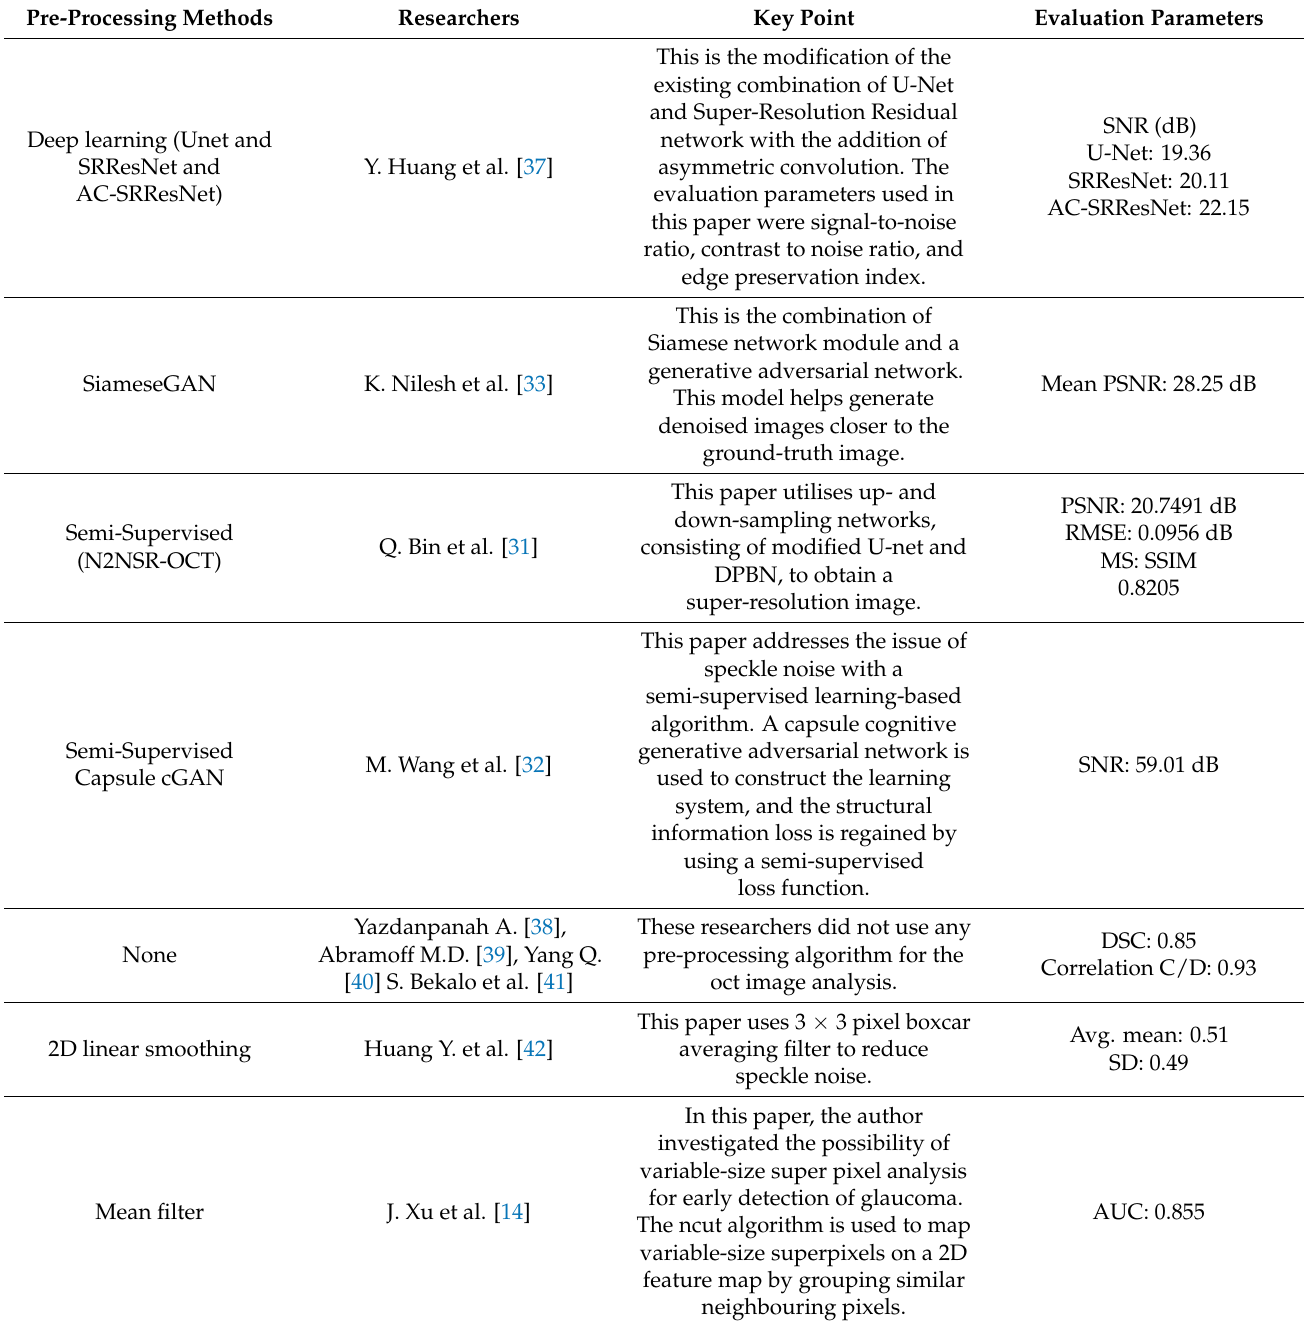
Table 2. Pre-processing algorithms used for OCT